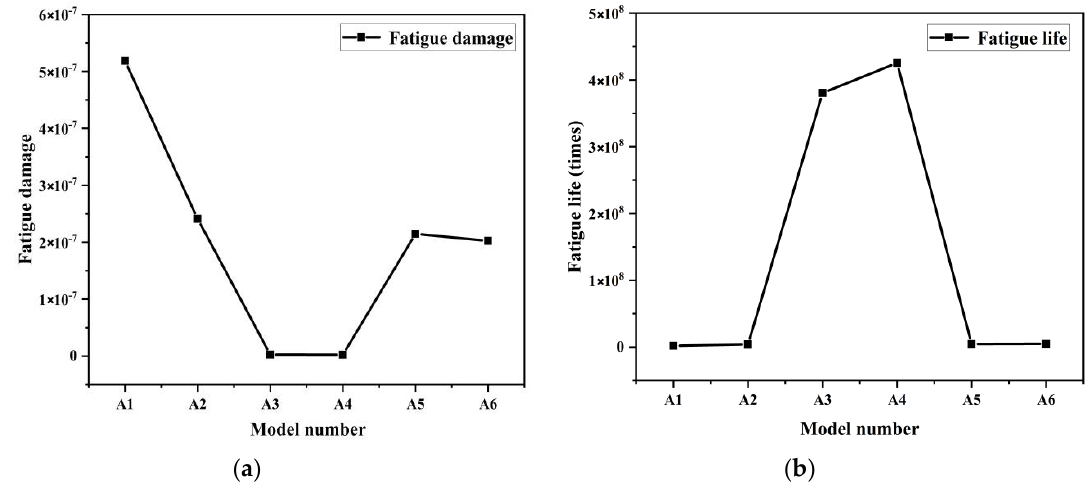
Figure 12. Variation curve of ( a ) fatigue damage and ( b ) fatigue life of the six models.